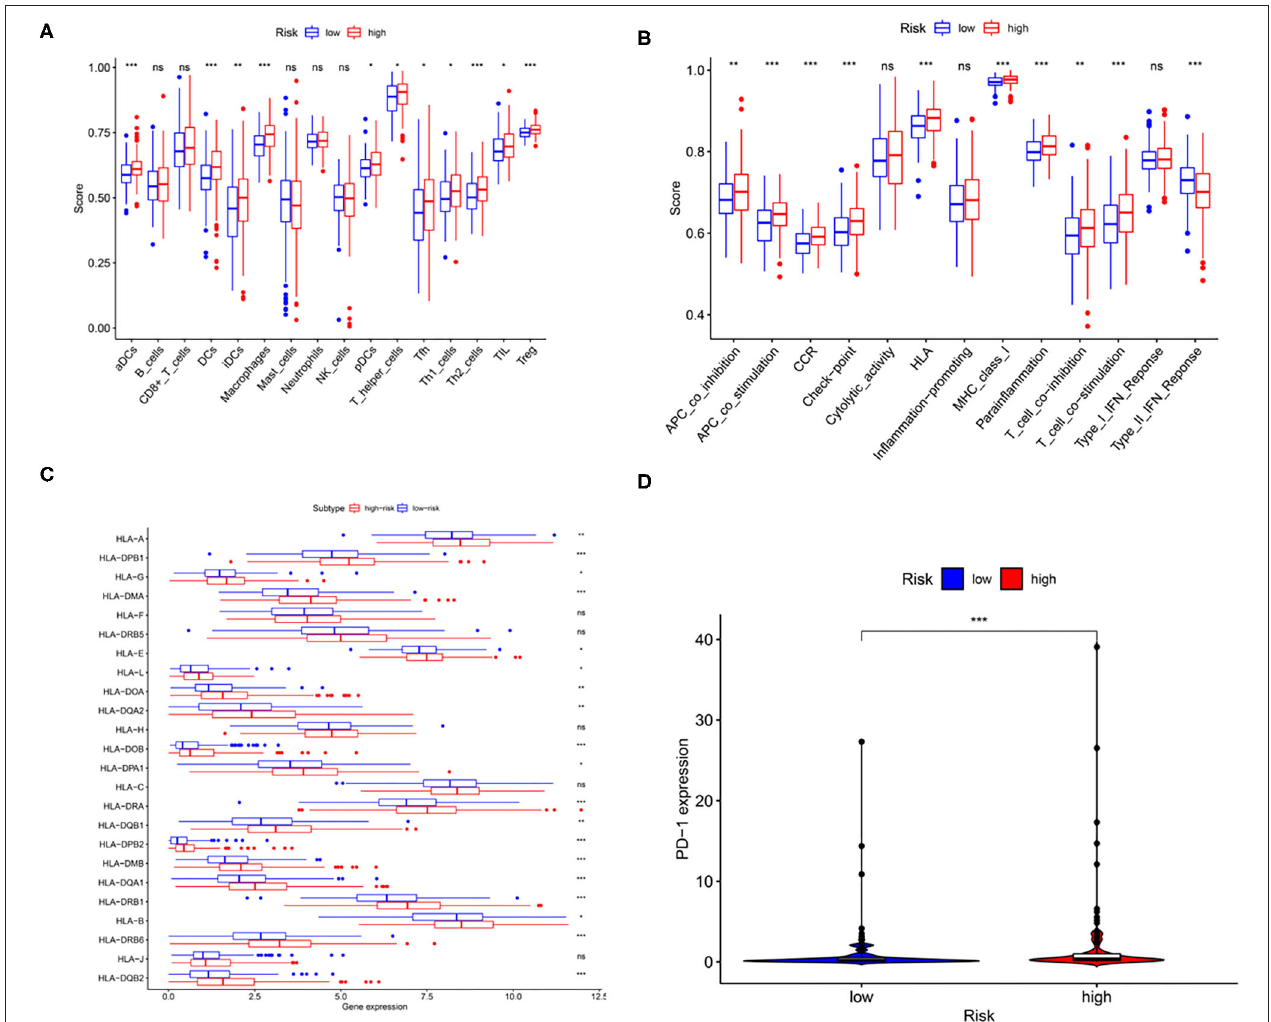
FIGURE 6 | The relationship among the risk scores, immune cell infiltration, and immune functionality in patients with liver cancer. The relative enrichment of immune cell infiltration (A) and immune functionality (B) in the patients with high- and low-risk liver cancer. HLA family gene (C) and PD-1 expression (D) in patients with high- and low-risk liver cancer. * p < 0.05; ** p < 0.01; *** p <